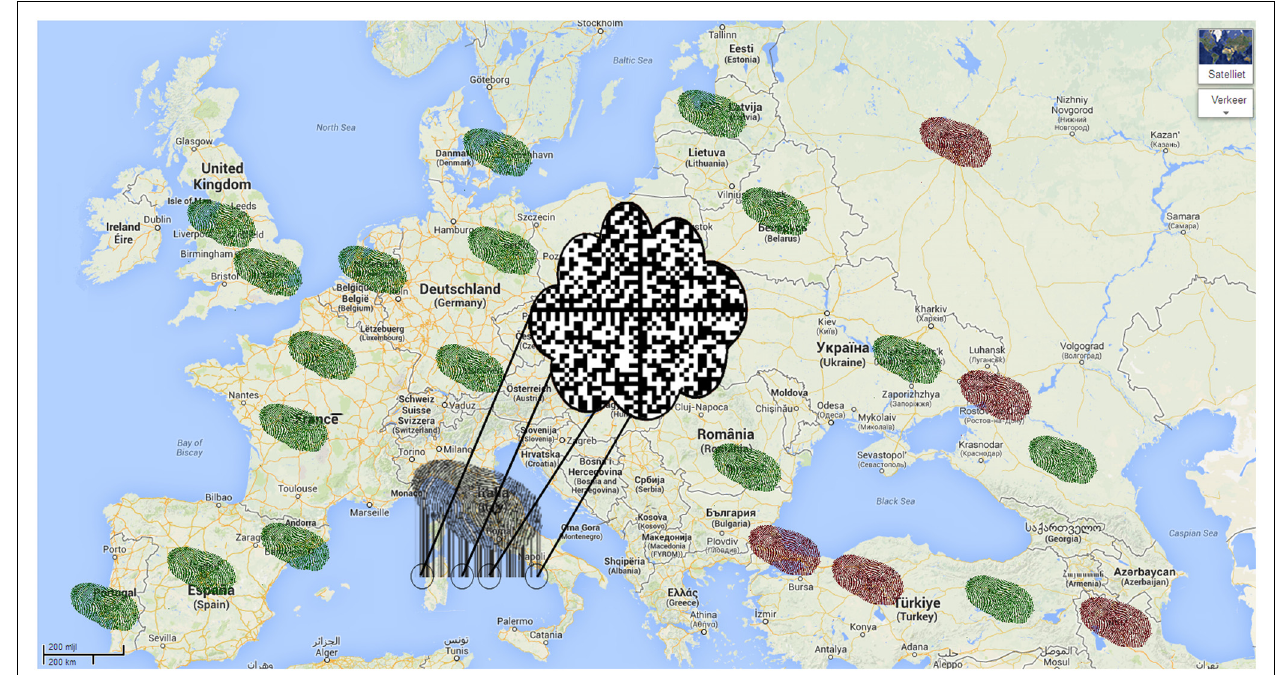
FIGURE 2 | Future perspective of integration of global omics signals. There is a centralized database containing molecular fingerprints of past cases, the “breath-cloud” (middle of the picture). Green fingerprints represent suspected cases that were found to be most similar to the